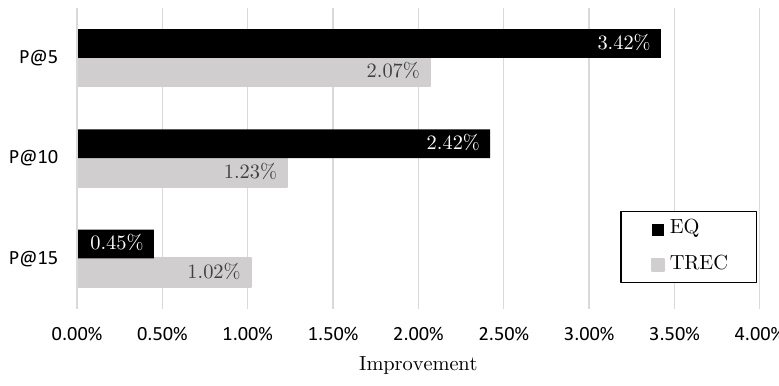
Figure 8. Comparison of the mean precision of the participants of the TREC2017 Precision Medicine Track (TREC) and the proposed method (EQ) in the top 15 retrieved documents.